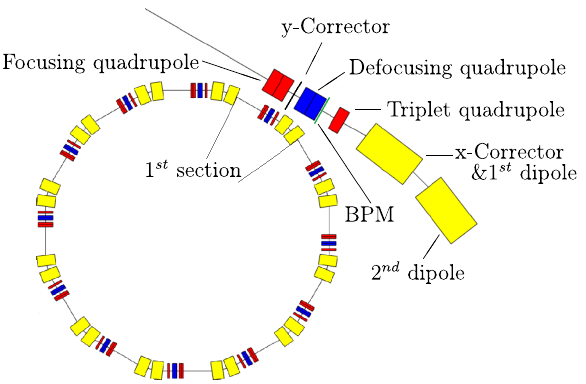
FIG. 1. Schematic of the lattice of the SIS18 synchrotron. The first section has been magnified on the top right, and the components are labeled. The horizontal correctors are located at the first dipole as extra windings in all sections except in the fourth and sixth sections, where they reside on the second dipoles (not labeled in the